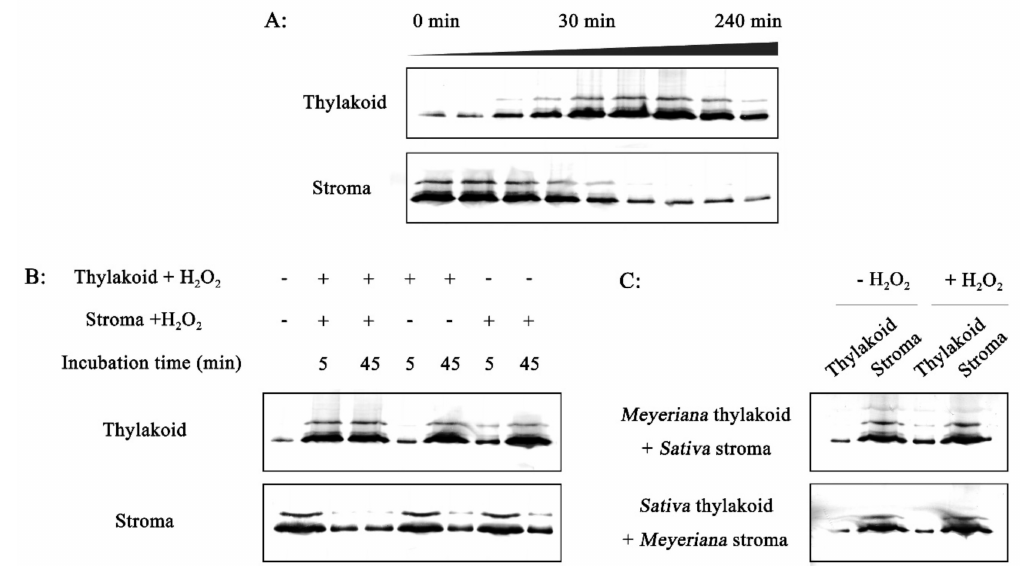
Figure 8. In vitro experiments on RCA association with the thylakoid membrane. ( A ) E ff ect of di ff erent treatment times of exposure to H 2 O 2 on the association of RCA with the thylakoid membrane of O. meyeriana . The suspension of ruptured chloroplasts was treated with H 2 O 2 during the 240 min. chase phase, and the chloroplasts were sub-fractionated into soluble stroma and thylakoid membrane fractions followed by separation of RCA proteins using SDS-PAGE. ( B ) E ff ect of pre-treatment with H 2 O 2 on the stroma or thylakoid membrane fractions of O. meyeriana . Intact chloroplasts isolated from leaves were ruptured into soluble stroma fraction and thylakoid membrane fraction, and each of the fractions was treated with H 2 O 2 for 30 min. before mixing and incubation. At 5 min. or 45 min. after mixing, samples were re-fractionated and the distribution of RCA protein was tested by SDS-PAGE. ( C ) E ff ect of pre-treatment with H 2 O 2 as in B but using mixtures of the stroma fraction from susceptible O. sativa with the thylakoid membrane fraction of O. meyeriana or vice